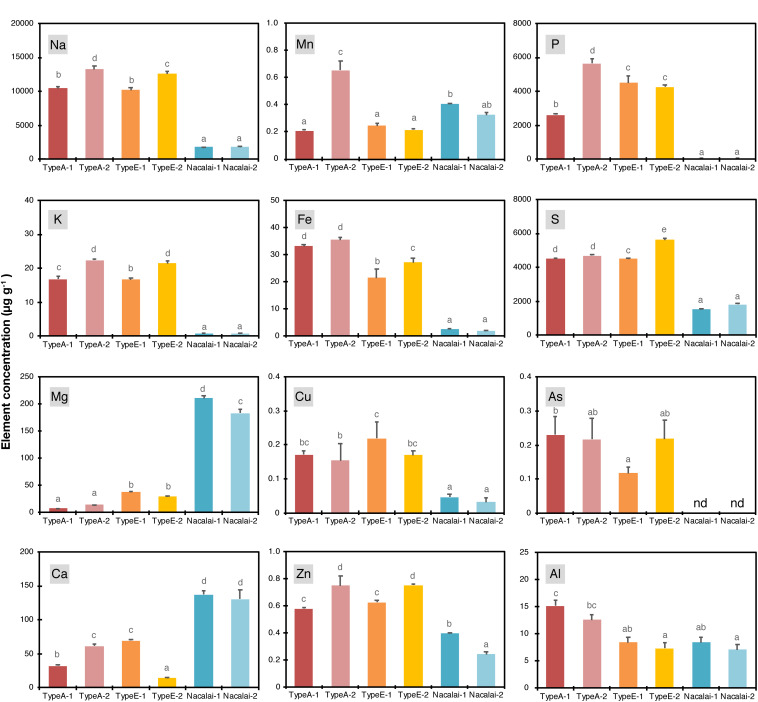
Concentrations of Na, K, Mg, Ca, Mn, Fe, Cu, Zn, P, S, As, and Al in the agar regents (μg g–1). Data represent means with standard deviation of at least three independent measurements. Means sharing the same letter are not significantly different within each panel (P < 0.05, Tukey’s HSD). n.d., not detected.